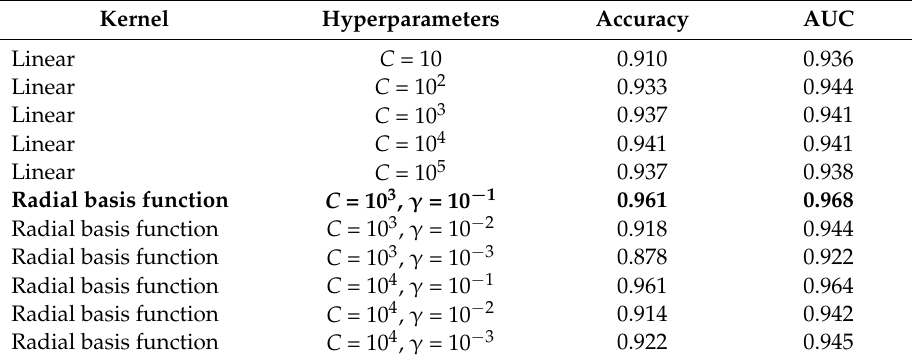
Table 5. Hyperparameter tuning of support vector machine classifier training.